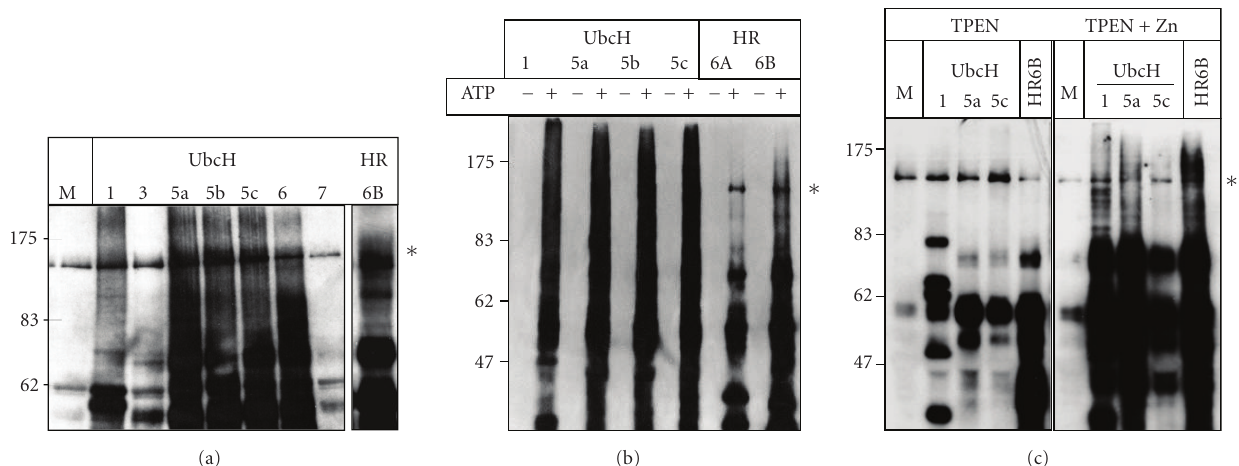
Figure 5: RFP has an E3 ubiquitin ligase activity. (a)–(c) Streptavidin peroxidase revelation of substrate-independent in vitro ubiquitination reactions using immunoprecipitated RFP (a) or GST-RING-B-box of RFP (GST-RING/RFP) (b), (c) as potential E3 ubiquitin ligase enzyme. Dark smears and signals higher than the biggest protein in the assay (monoubiquitinated E1 enzyme indicated by the asterisk) reflected polyubiquitinated products. E2 enzymes are indicated on the top part of each figure. M: master mix containing all the components of the system except E2 enzymes. Sizes (kDa) are indicated. (a) RFP protein immunoprecipitated from 15P-1 cell overexpressing Myc-RFP. Polyubiquitination is observed when UbcH1, UbcH5a, 5b, 5c, UbcH6, or HR6B are used as E2 enzymes. (b) Reactions are performed in presence or in absence of ATP. As expected mono- and poly-ubiquitinations are only observed in presence of ATP. (c) Prior to the substrate- independent in vitro ubiquitination reaction, GST-RING/RFP was pretreated with TPEN (left panel) in order to chelate Zn 2+ and destroy RING finger architecture, or pretreated with TPEN, washed, and incubated with an excess of Zn 2+ (right panel). As expected, when GST- RING/RFP was treated with TPEN, only mono-ubiquitination can be observed (left panel) and incubation of TPEN treated GST-RING/RFP with an excess of Zn 2+ restores E3 ubiquitin ligase activity (right